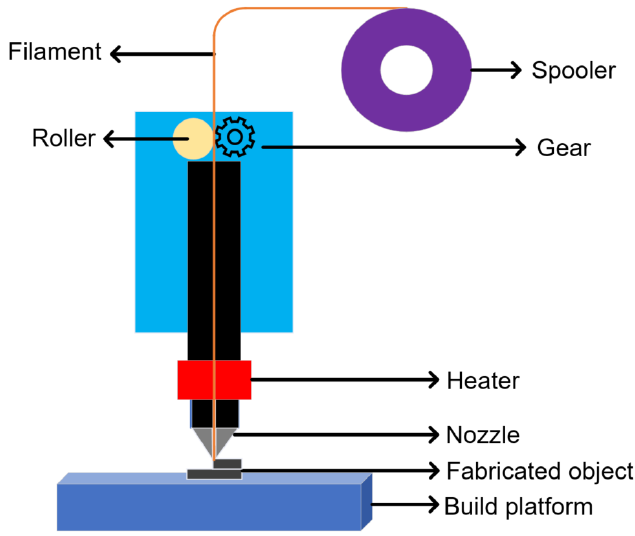
Figure 1. A schematic of the FDM